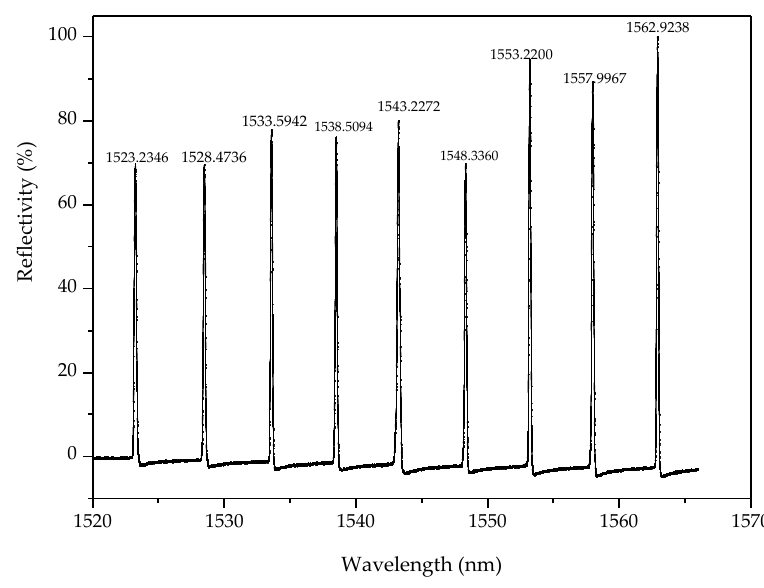
Figure 2. The schematic diagram of one FBG array full spectrum.